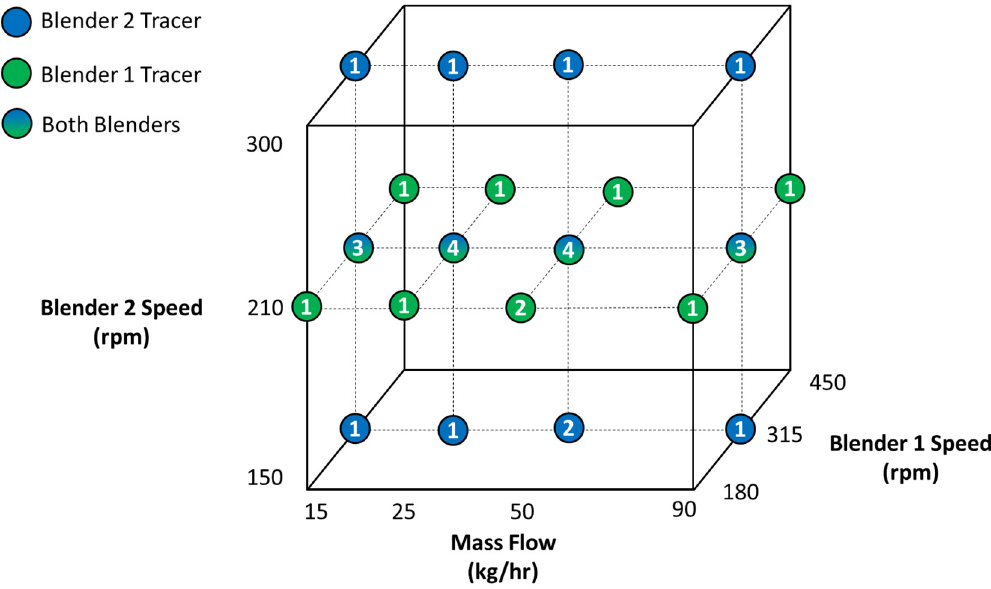
Figure 5. Summary of RTD Impulse Experiments.